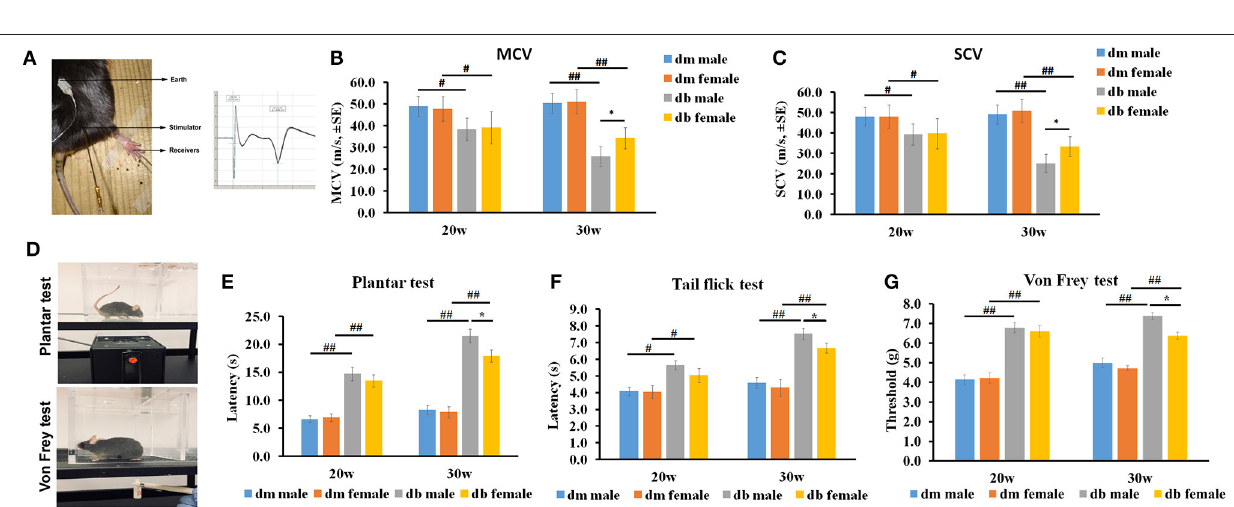
FIGURE 3 | The differences of nerve conduction velocity and behavioral assays between males and females. (A) shows the electrophysiological recording of stimulated sciatic nerve in mice aged 20 ∼ 30 weeks. Analysis of motor ( B ; MCV) and sensory ( C ; SCV) nerve conduction velocity shows that male diabetic mice displayed lower MCV and SCV velocity than female db/db mice at 30 weeks but not at 20 weeks, indicating that male diabetic mice have severe electrophysiological deficits. Both male and female db/db mice demonstrated decreased MCV and SCV compared to age matched male and female db/m mice. (D) Shows the IITC Plantar Analgesia Meter and Von Frey test system. (E-G) show that male diabetic mice exhibited increased thermal latency and thresholds for mechanical stimuli than female diabetic mice aged 30 weeks as measured by Plantar test (E) , Tail flick test (F) , and Von Frey test (G) . Both male and female db/db mice showed increased thermal latency, decreased mechanical sensitivity compared to age matched male and female db/m mice. # P < 0.05, ## P < 0.01 db/m male group vs. db/db male group, db/m female group vs. db/db female group; * P < 0.05, db/db male group vs. db/db female group, N = 10/group. dm = db/m mouse; db = db/db mouse.